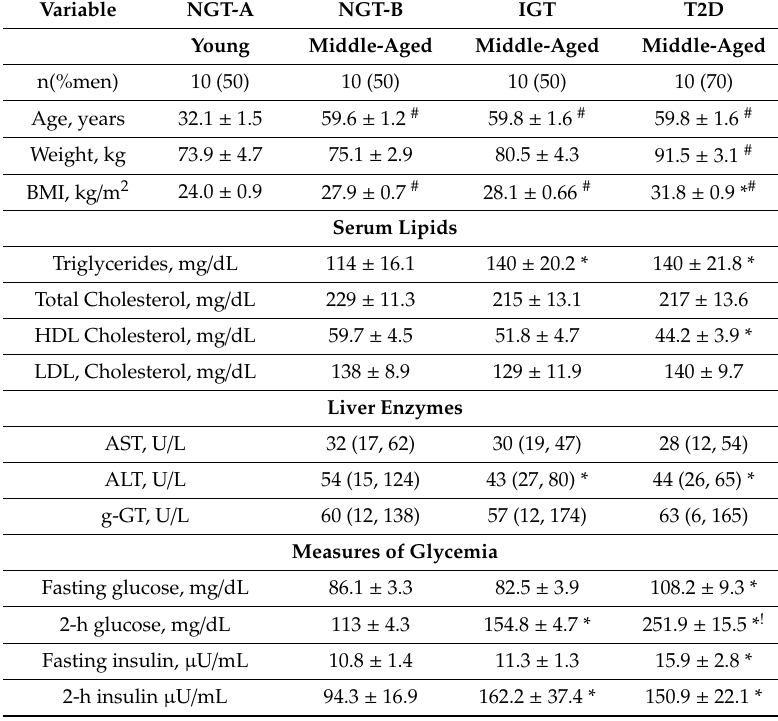
Table 1. Patient Characteristics. NGT-normal glucose tolerance; IGT-impaired glucose tolerance; T2D-type 2 diabetes; Weight; BMI-body mass index; HDL-high density lipoprotein; LDL-low